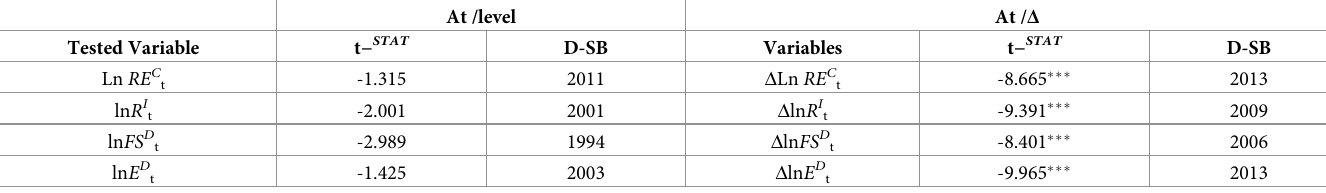
Table 3. Findings of Zivot-Andrews test. At /level At / Δ Tested Variable t − STAT D-SB Variables t − STAT D-SB -1.315 2011 Δ Ln RE C t -8.665 ��� 2013 -2.001 2001 Δ ln R I t -9.391 ��� 2009 -2.989 1994 -8.401 ��� 2006 -1.425 2003 -9.965 ���